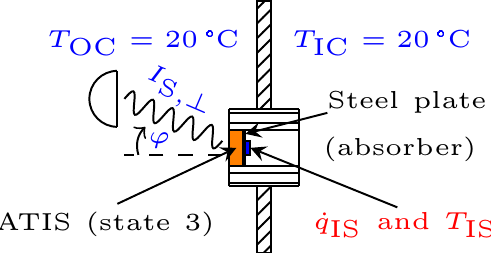
Figure 4. Experimental setup for the determination of the angle-dependent total solar energy